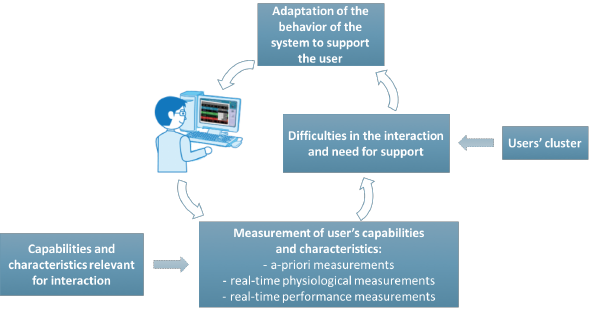
Figure 1: Work flow of the proposed approach.